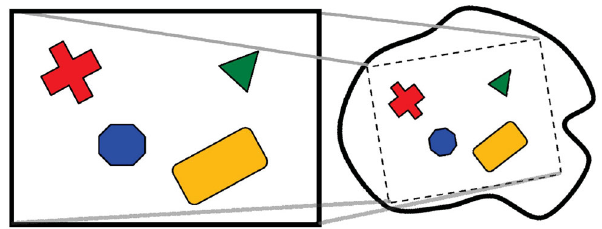
Fig. 2 An example of the virtual projection